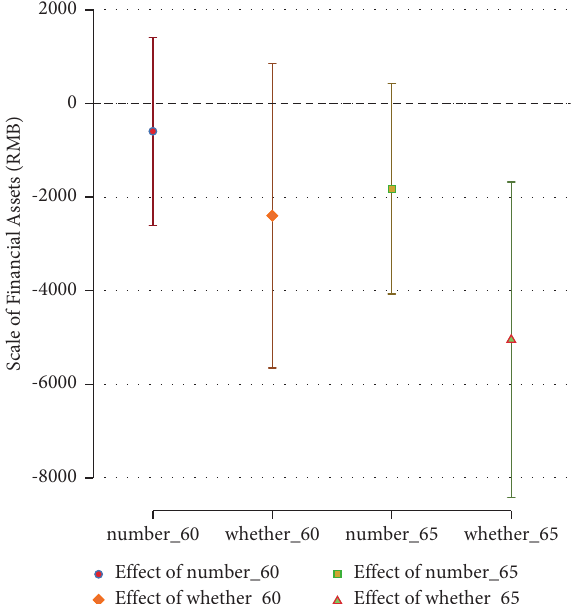
Figure 2: Point estimates and 95% confidence intervals of aging’s effects on the scale of financial